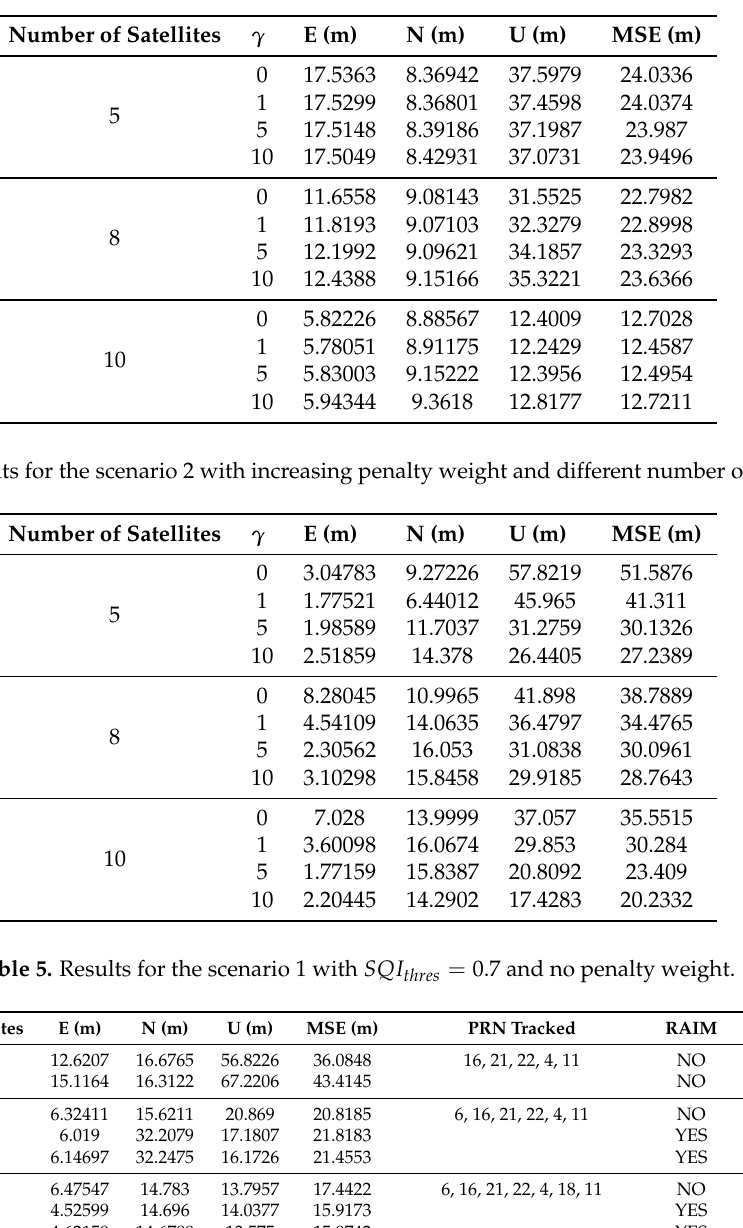
Table 3. Results for the scenario 1 with increasing penalty weight and different number of satellites.